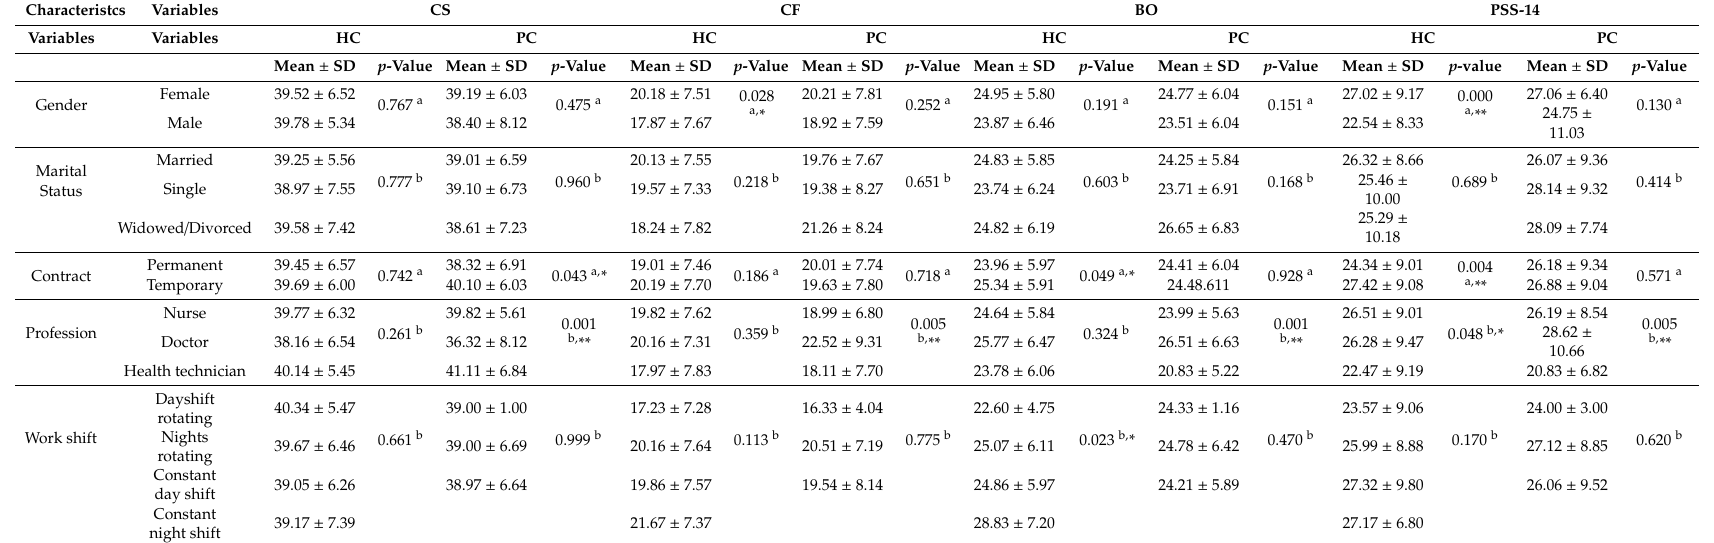
Table 3. Professional quality of life and perceived stress, according to socio-demographic and occupational characteristics: primary and hospital care.